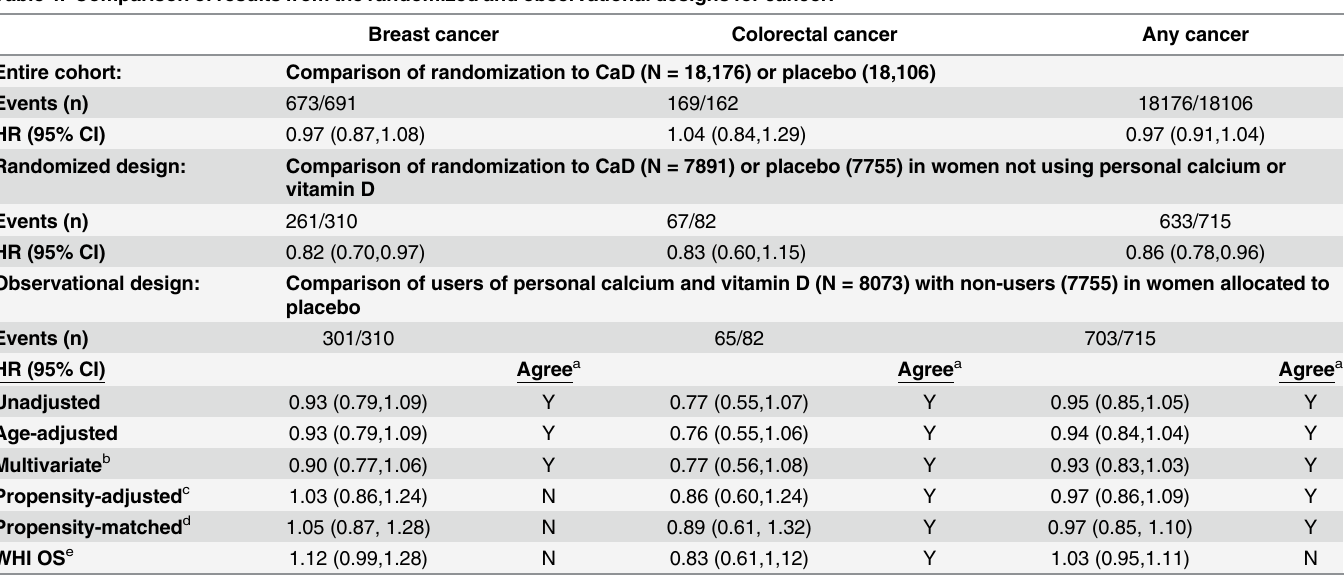
Table 4. Comparison of results from the randomized and observational designs for